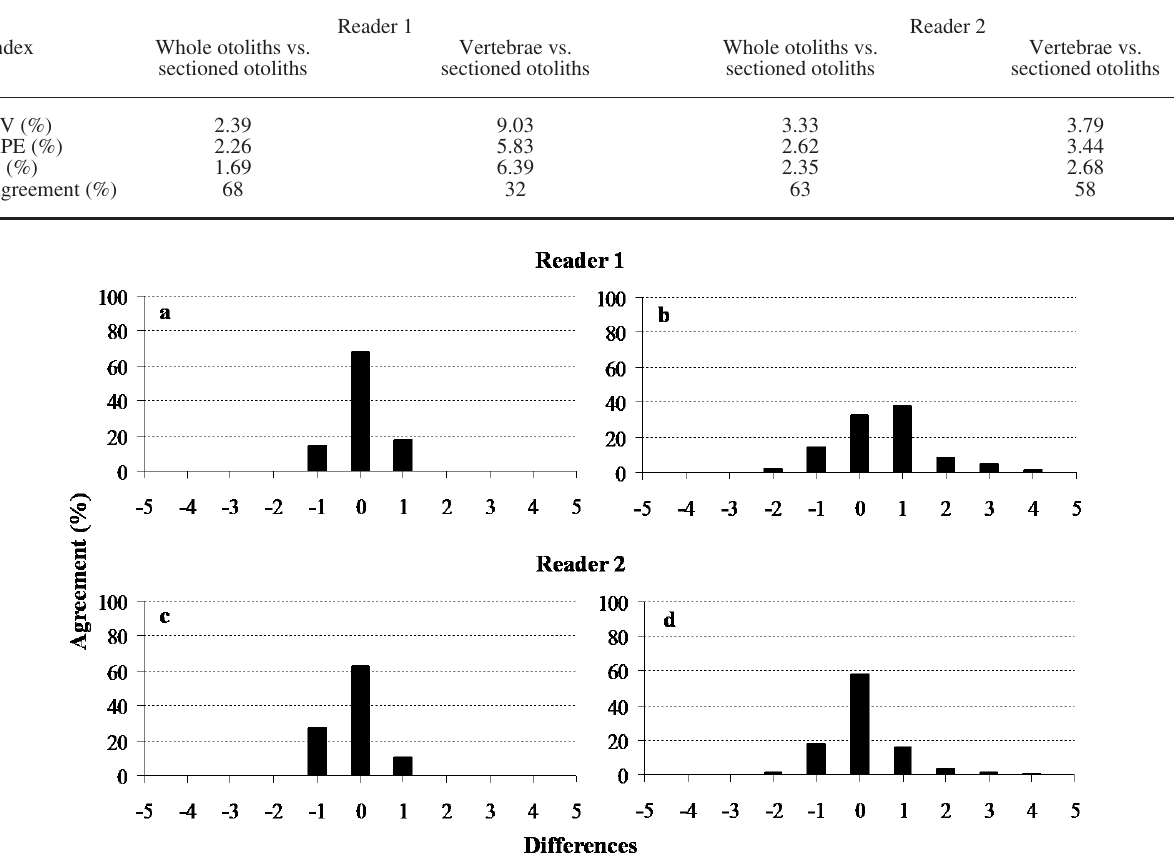
Fig . 7. – Bias plot comparing ageing preparation methods for each reader based on Aphanopus carbo ; (a) and (c) between whole and sectioned otoliths; (b) and (d) between vertebrae and sectioned